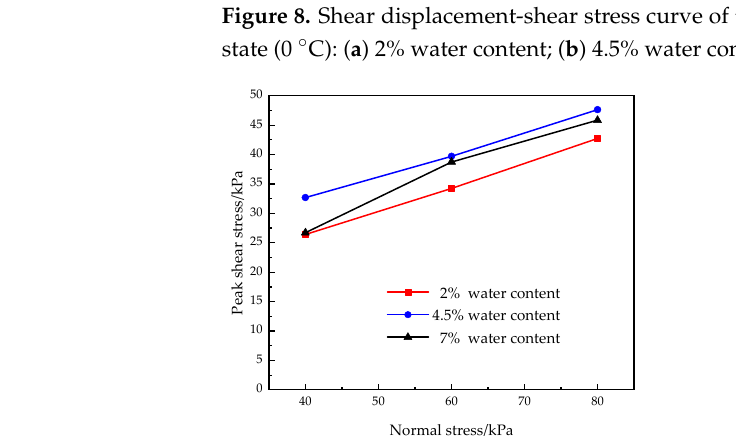
Figure 9. The relationship curve between the shear strength and normal stress of the reinforced soil interface under a nonfreezing state (0 °C).